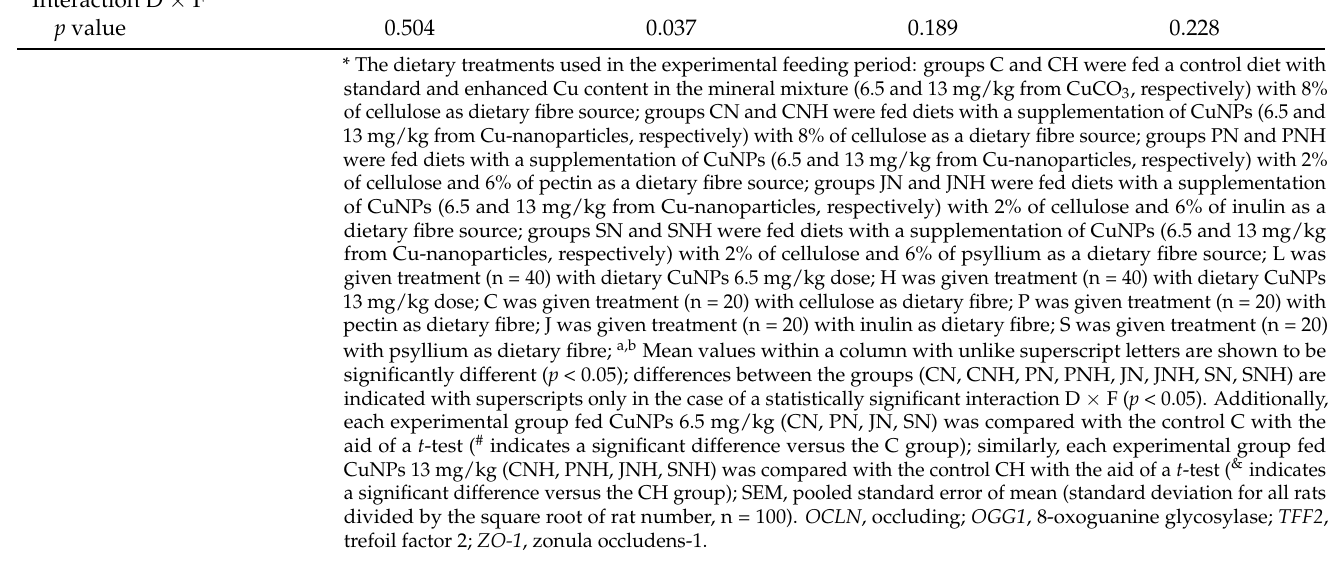
Table 7. Cont. OCLN